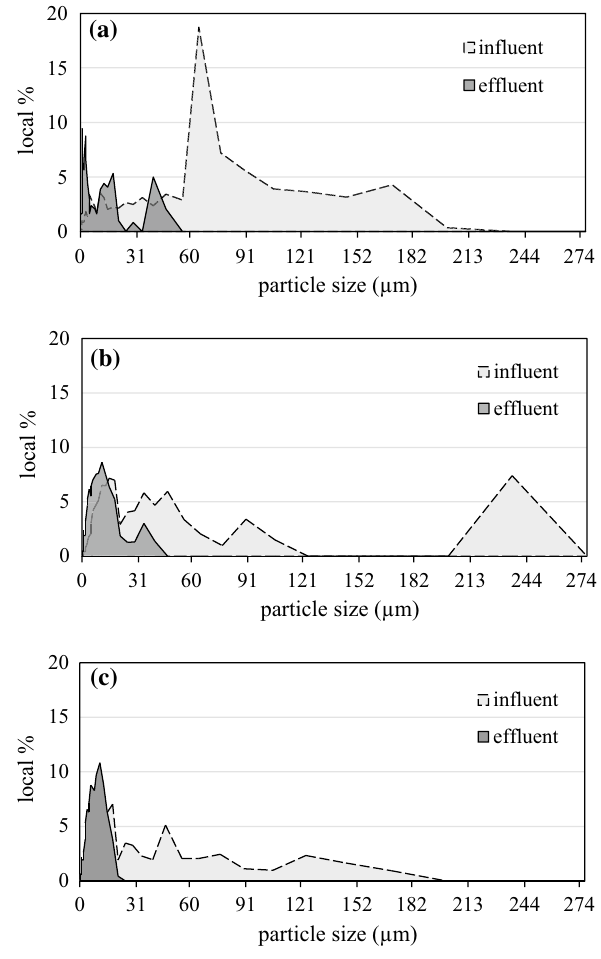
Fig. 5 Particle size distribution before (influent) and after (effluent) disinfection: a diluted wastewater, b ECT wastewater, c raw waste-